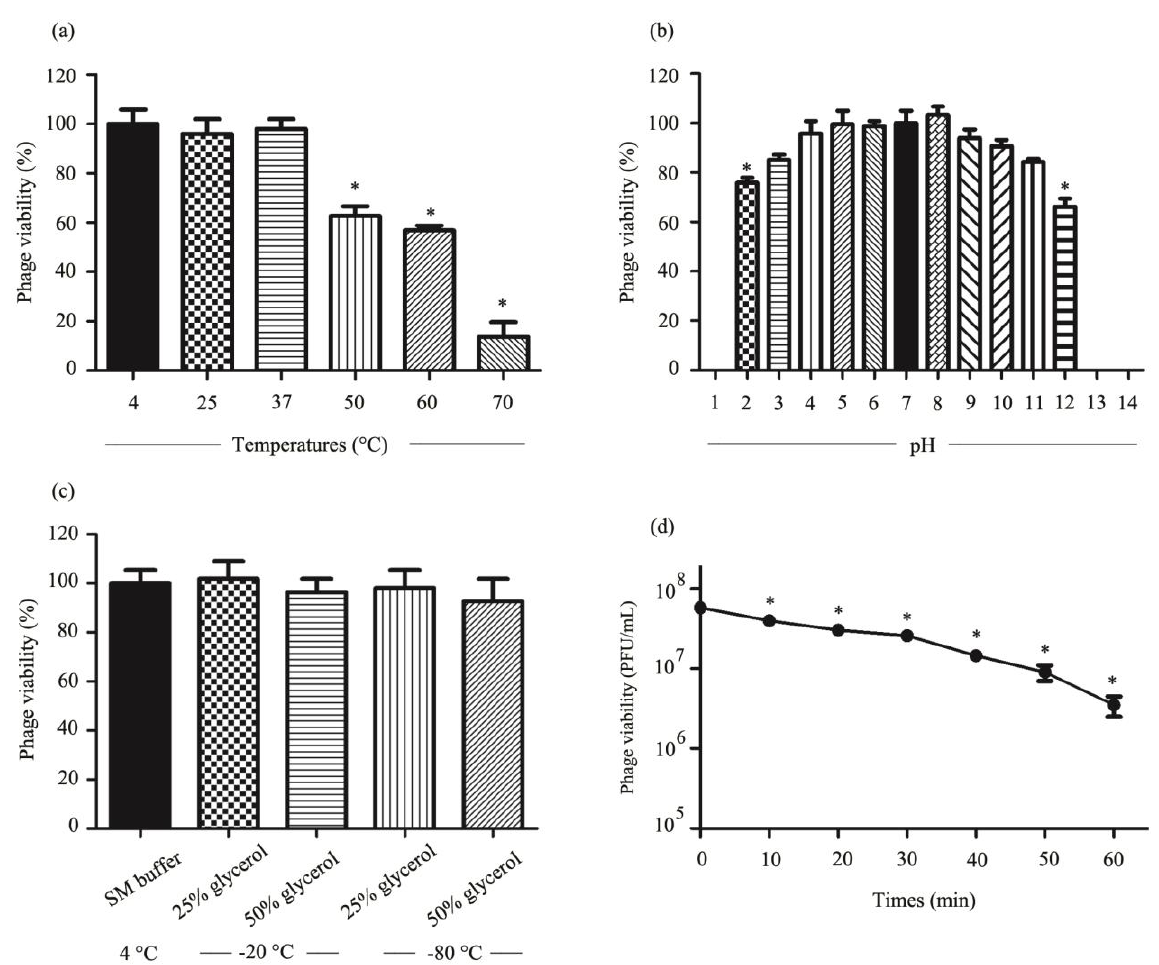
Figure 3. Stability of phage vABPW7 under different conditions. ( a ) Thermal stability of phage vABPW7 incubated at different temperatures for 2 h. ( b ) pH stability of phage vABPW7 incubated at different pHs for 2 h. ( c ) Stability of phage vABPW7 under varied concentrations of glycerol at − 20 ◦ C and − 80 ◦ C for 30 days ( d ) UV stability of phage vABPW7. Experiments were undertaken independently in duplicate with duplicate assay. The data show the mean ± SEM (*, P value < 0.05).